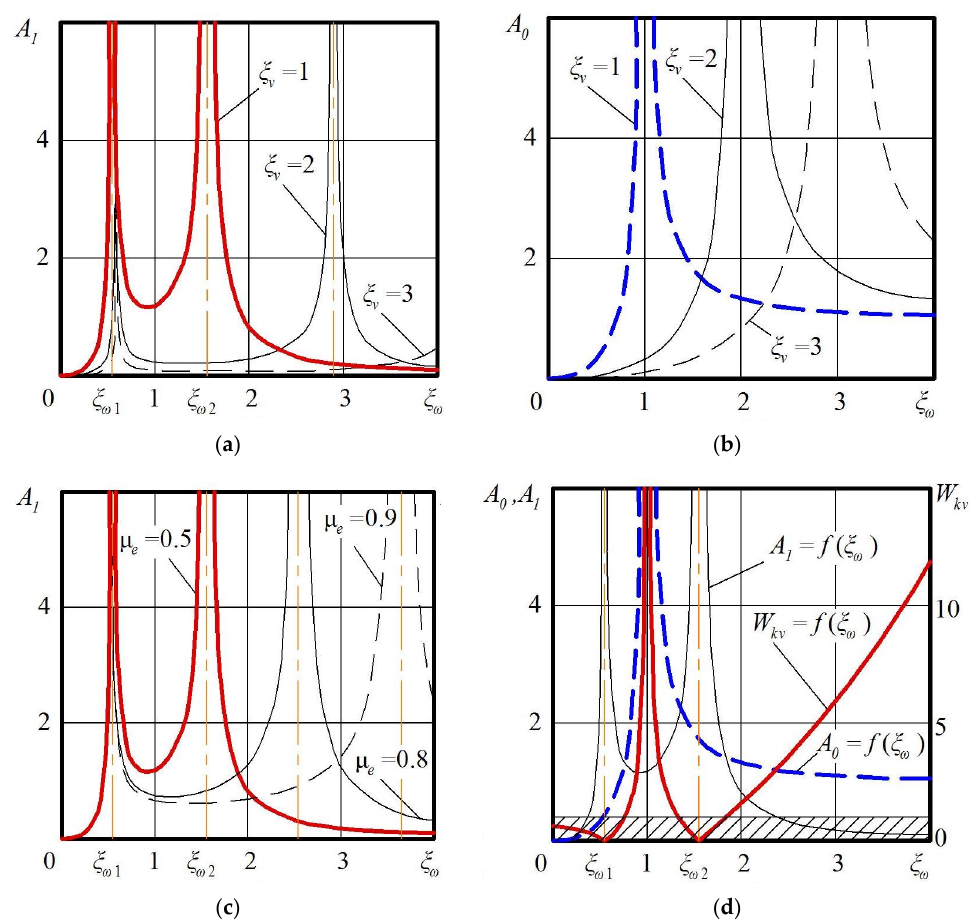
Figure 5. Function graphs: ( a )— A 1 = f ( ξ ω ) for di ff erent ξ v ; ( b )— A 0 = f ( ξ ω ) for di ff erent ξ v ; ( c )— A 1 = f ( ξ ω ) for di ff erent µ e ; ( d ) —W kv = f ( ξ ω ).